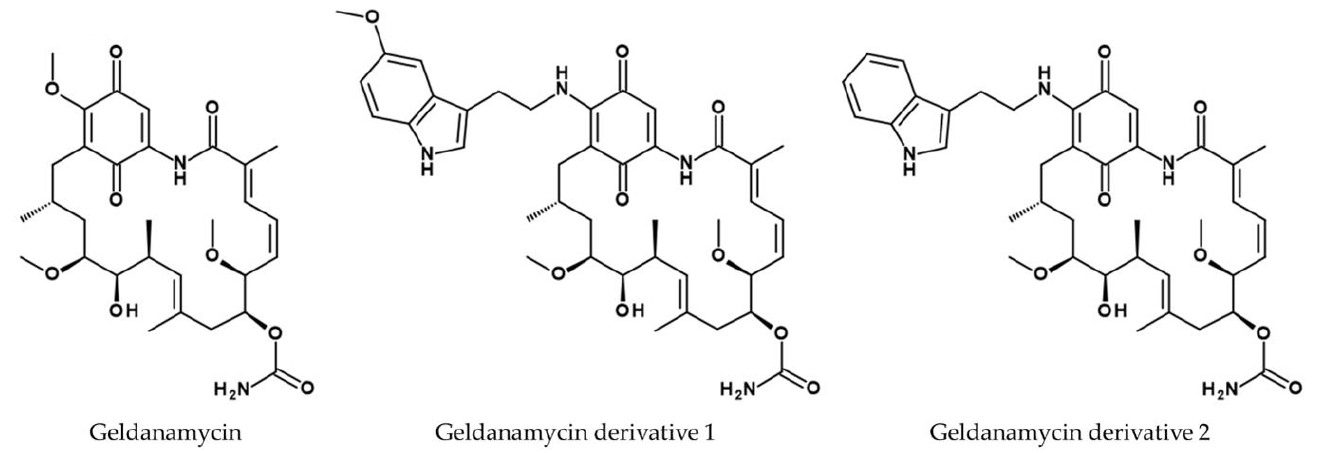
Figure 10. Structures of geldanamycin, 17-(tryptamine)-17-demethoxy geldanamycin (derivative 1) and 17-(5 ′ -methoxytryptamine)-17-demethoxygeldanamycin (derivative 2) [157]. Seven fluvirucins (A 1 , A 2 , B 1 , B 2 , B 3 , B 4 , and B 5 ) were purified from extracts of five unidentified Actinomycetes species Q464-31, R869-90, R359-5, R516-16, and L407-5, revealing the following ID 50 values for compound A1 10.72 µ M, A2 9.37 µ M, B1 5.19 µ M, B2 21.67 µ M, B3 10.07 µ M, B4 32.78 µ M, and B5 > 82.78 µ M, respectively, against an unspecified IAV [158].